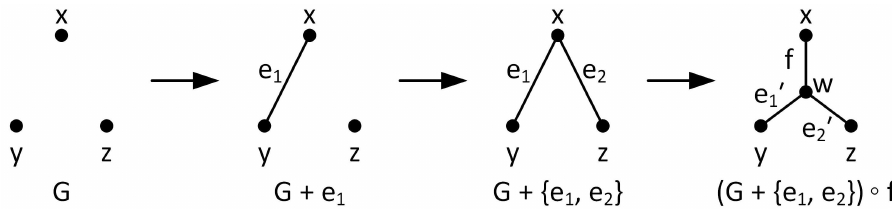
Figure 8. Operation D3 interpreted as two edge additions followed by a vertex split.